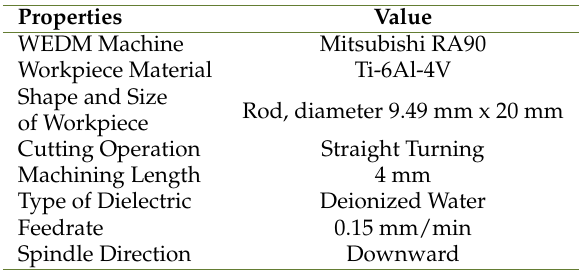
Fig. 1. Workpiece deflection effects of cutting force [2]